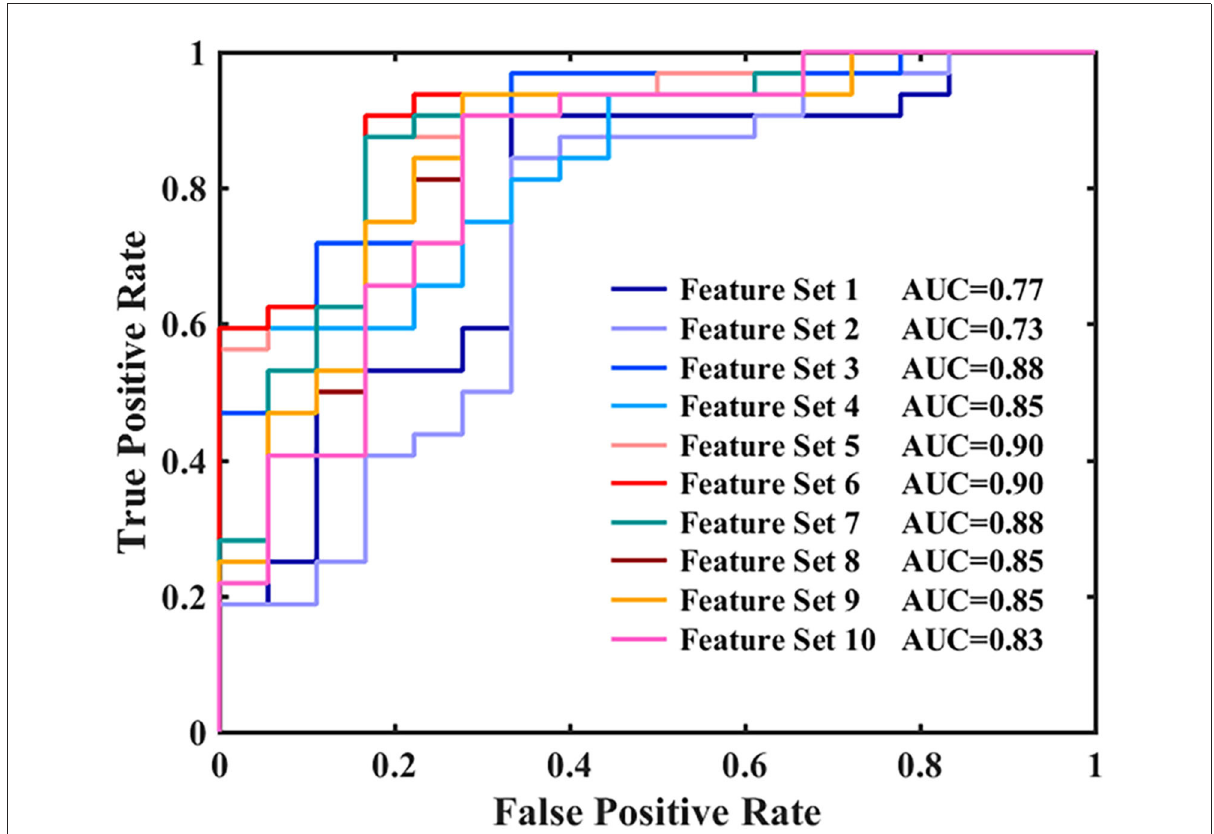
FIGURE3 Receiver operating characteristic (ROC) curves and areas under the curves (AUCs) for each classifier when using feature